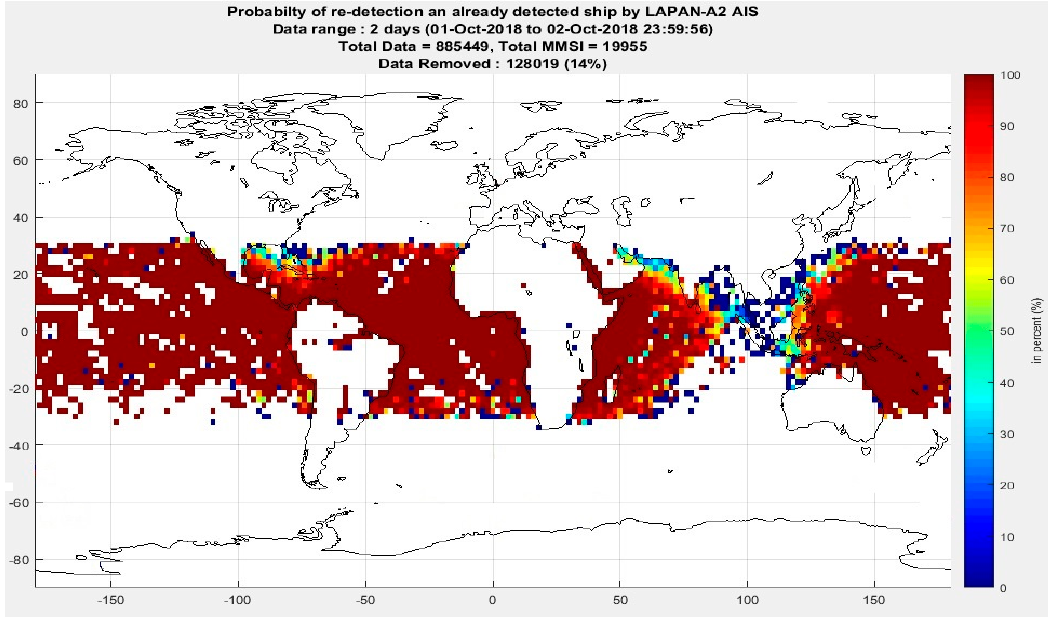
Figure 8. The re-detection probability of LAPAN-A2 AIS generated using dataset acquired on 1 October 2018, 00:00:00 UTC to 2 October 2018, 23:59:56 UTC.